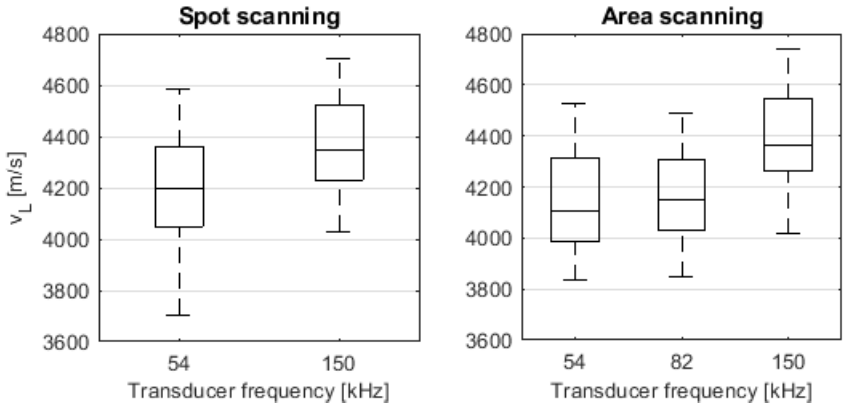
Figure 4. Box plots of test